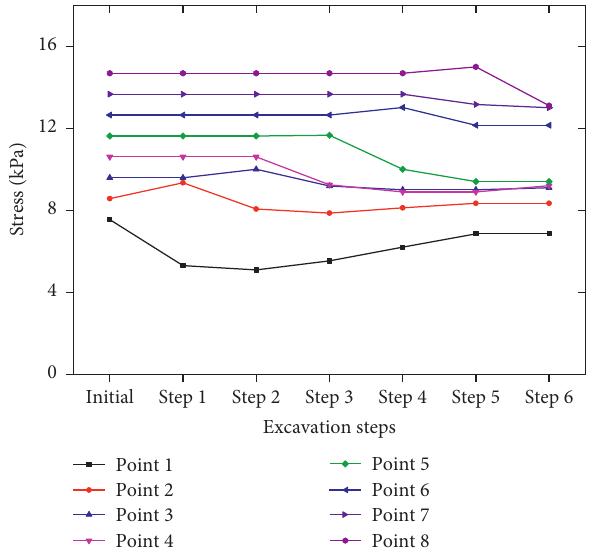
Figure 4: Stress changing of each testing point in stope roof after extraction (20 ° ).